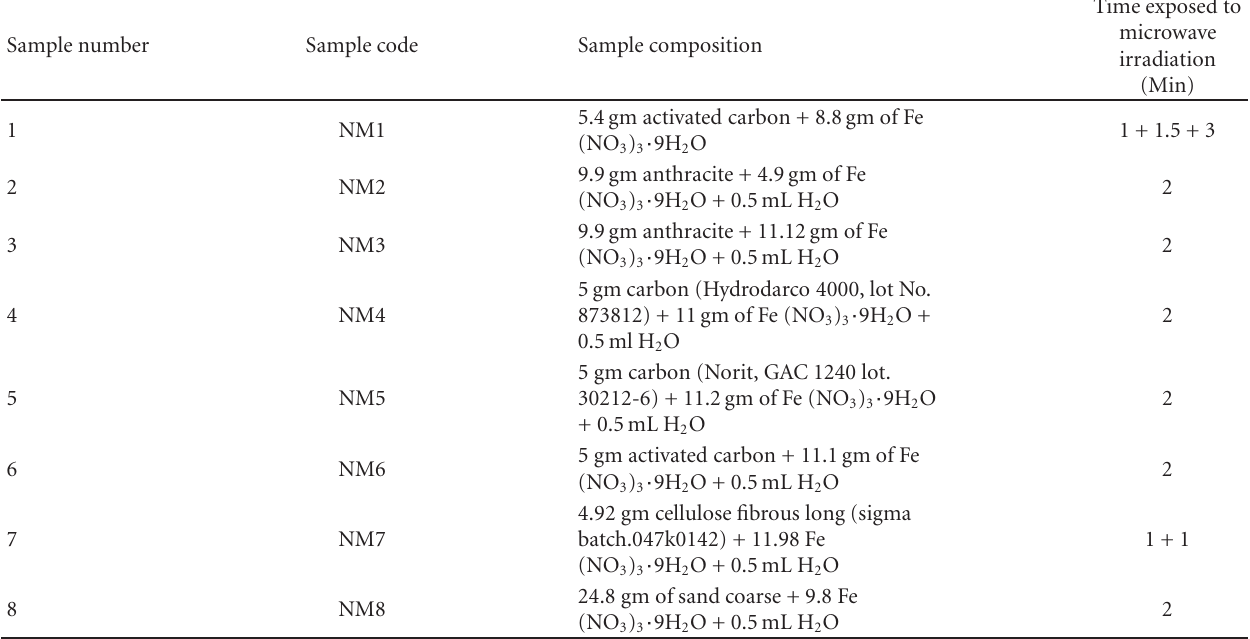
Table 1: Code, composition, and time of exposure of the reaction mixture.